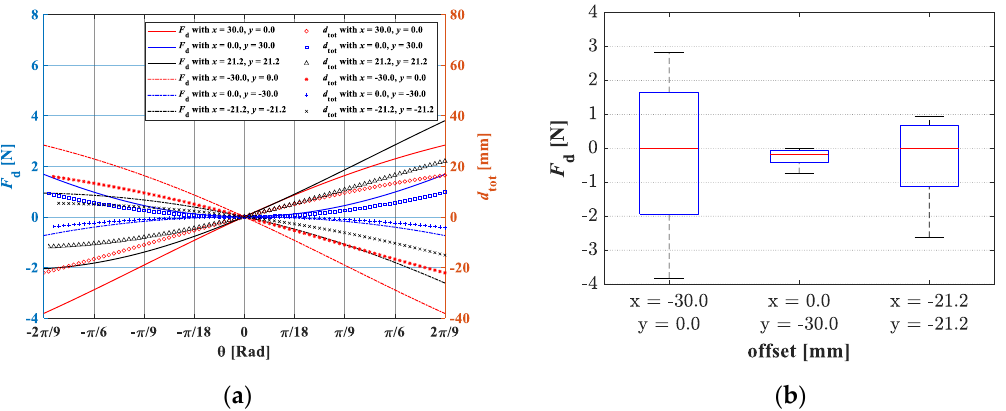
Figure 11. ( a ) Influences of the offset direction; ( b ) comparisons of offset direction.